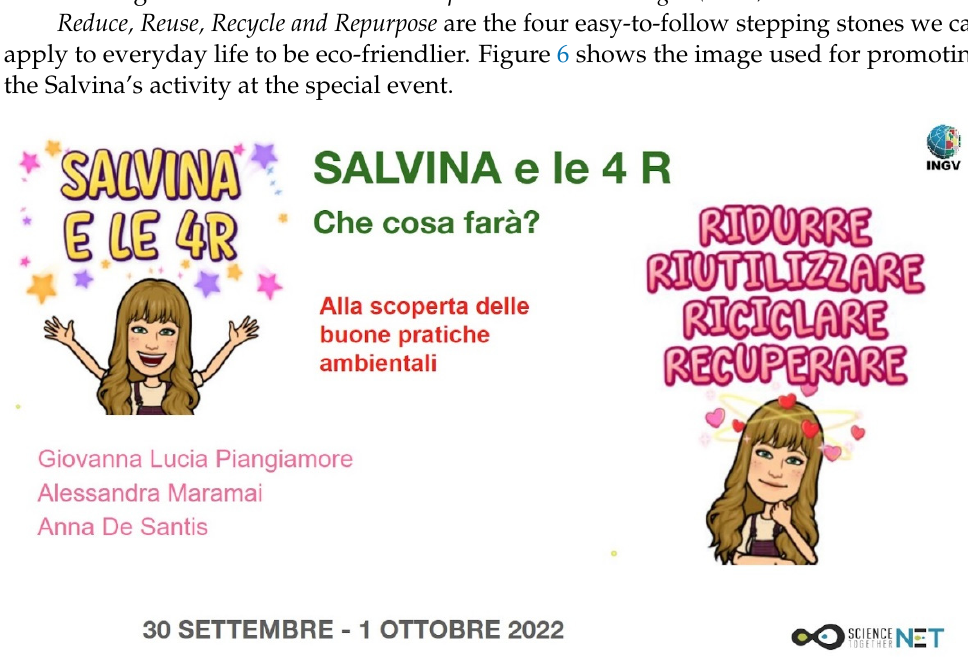
Figure 6. Poster of the Salvina and the 4Rs discovering eco-friendly behaviors, played in person at the European Researchers’ Night 2022 .